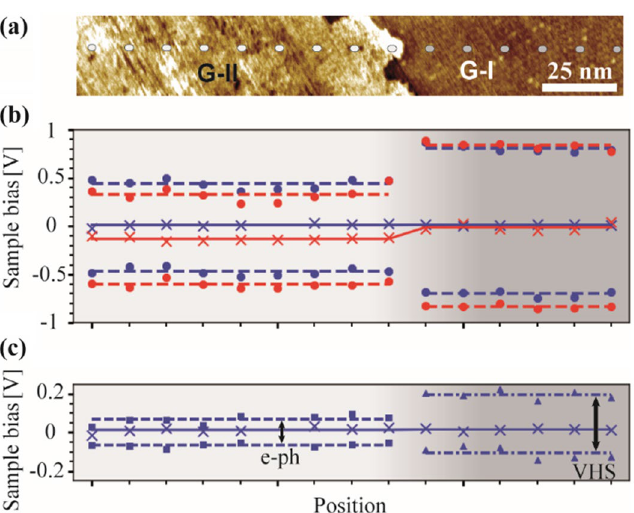
Figure 7. STS features along a line crossing different SLG regions from regime G-II at the left to regime G-I on the right. ( a ) STM image ( V bias = 1.0 V, I set = 0.4 nA) of the two different SLG regions marking the 15 STS measurement positions. ( b ) Position-dependent Dirac points (cross) and main STS peaks (circle) for I set = 0.22 nA (blue) and I set = 0.35 nA (red). ( c ) Position-dependent Dirac points (cross), electron phonon peaks (square) and Van Hove singularity peaks (triangle) ( I set = 0.22